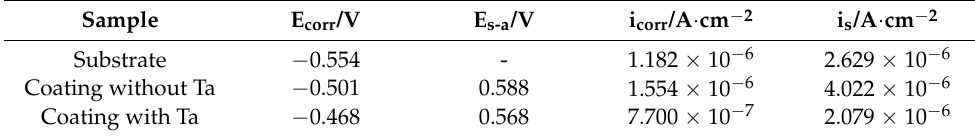
Figure 6. Potentiodynamic anodic polarization curves of the samples in NaOH solution (pH = 11). Table 4. Electrochemical parameters obtained from Figure